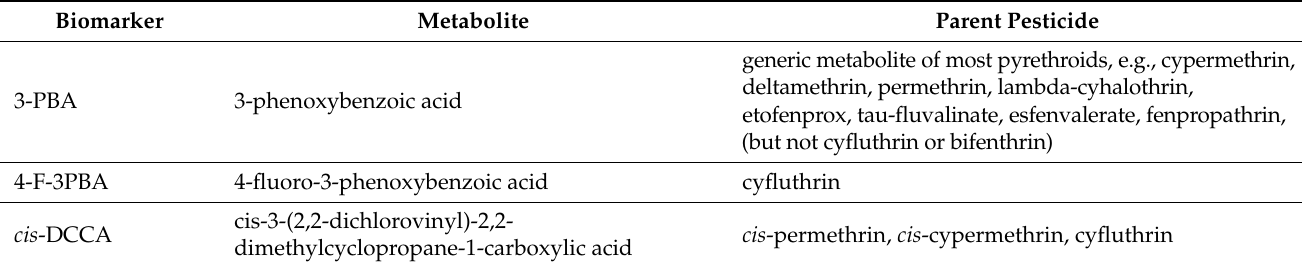
Table 1. Urinary biomarkers for pyrethroids, chlorpyrifos, and